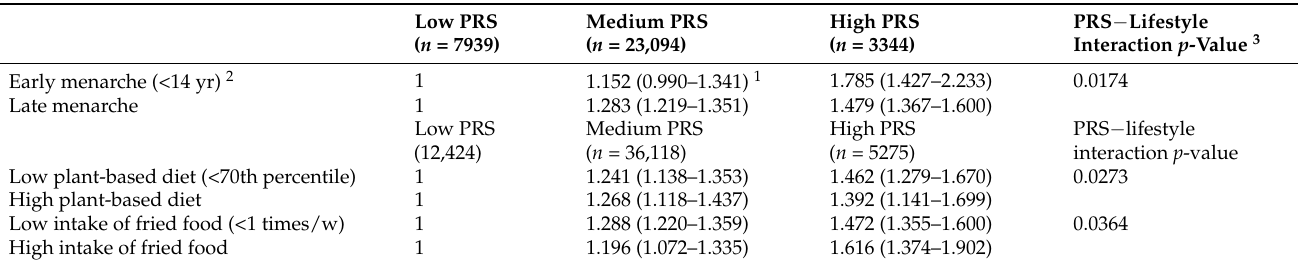
Table 6. Adjusted odds ratios for obesity risk by polygenetic risk scores (PRS) of the best model for gene − gene interaction after covariate adjustments according to lifestyles